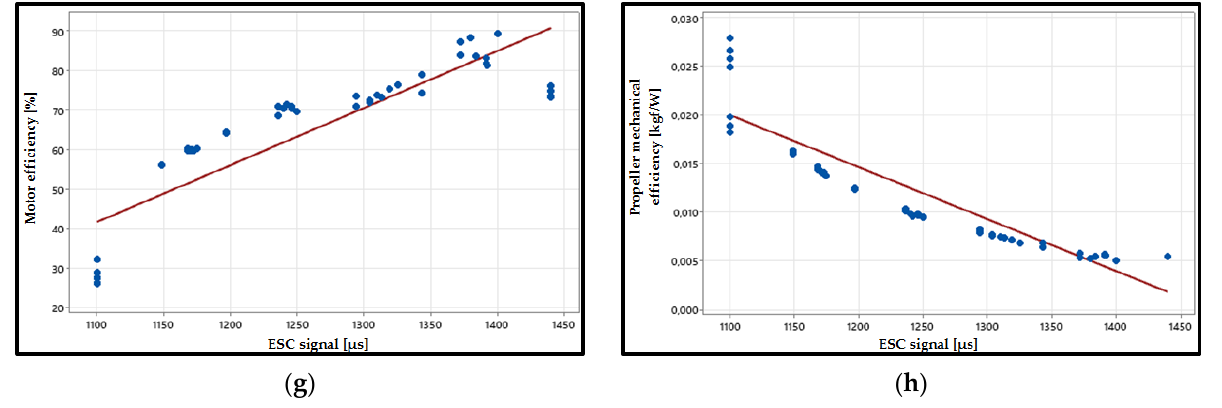
Figure 9. BLDC motor test results: ( a ) Dependence between thrust and ESC signal; ( b ) dependence between torque and ESC signal; ( c ) dependence between current and ESC signal; ( d ) dependence between electrical power and ESC signal; ( e ) dependence between motor electrical speed and ESC signal; ( f ) dependence between motor mechanical power and ESC signal; ( g ) dependence between motor efficiency and ESC signal; ( h ) dependence between propeller mechanical efficiency and ESC